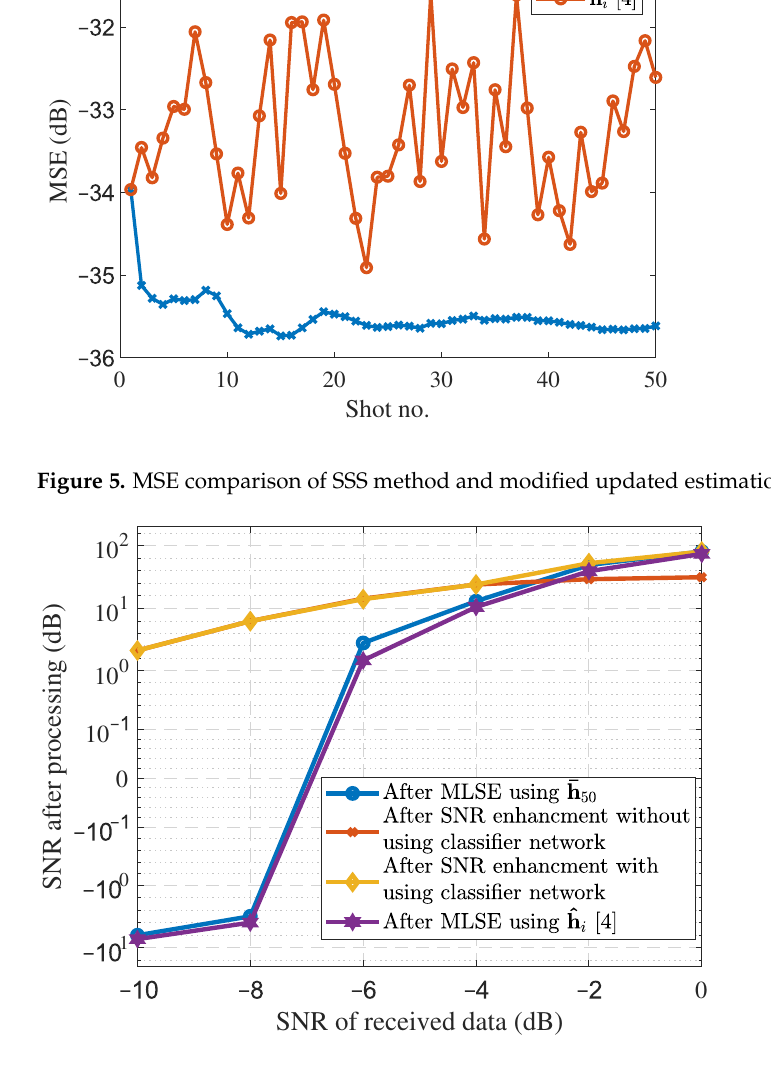
Figure 6. SNR enhancement using deep convolutional neural network, SNR of the received data y ( n ) versus SNR of the reconstructed traces after